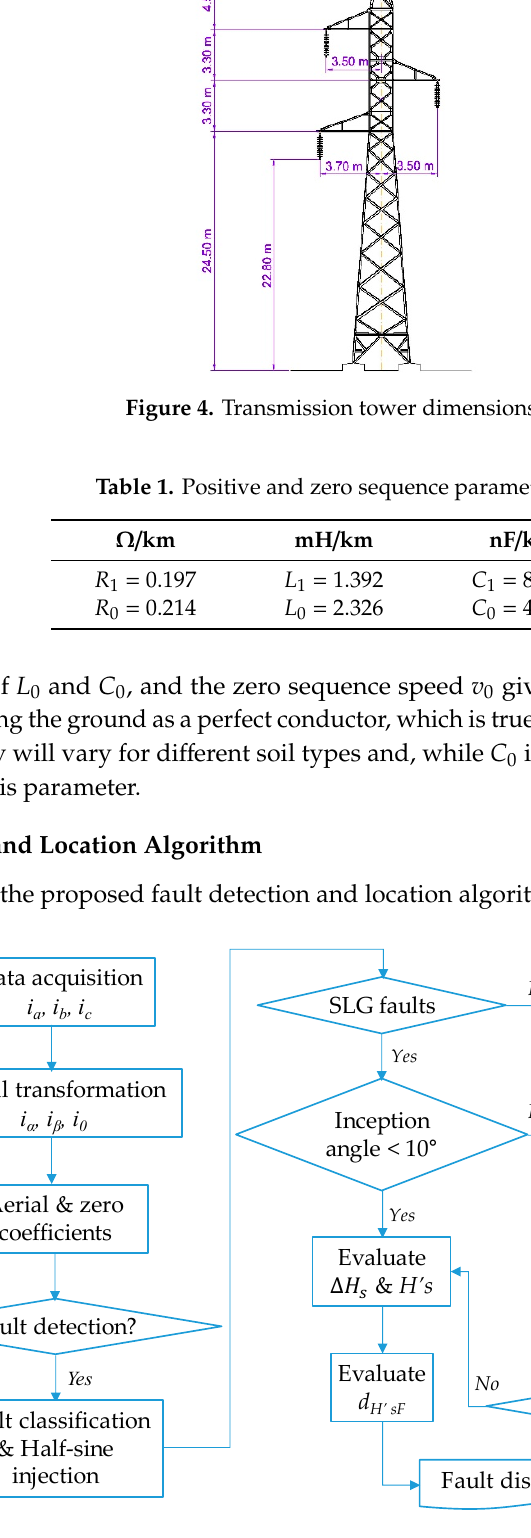
Figure 5. Fault detection and location scheme, where d_wt is the distance calculated by wavelet transform (WT), Blind_d is the blind zone of the wavelet method and d H’sF the distance obtained by the H’ s method.